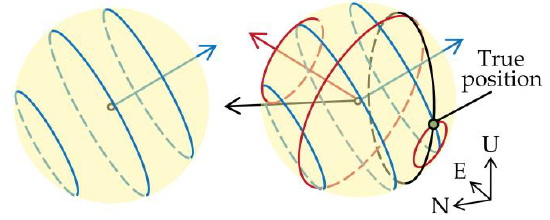
Figure 2. Relationship between the baseline vector and the fractional parts of the DD carrier phases. Table 1. Satellite geometry distribution for Figure 2.